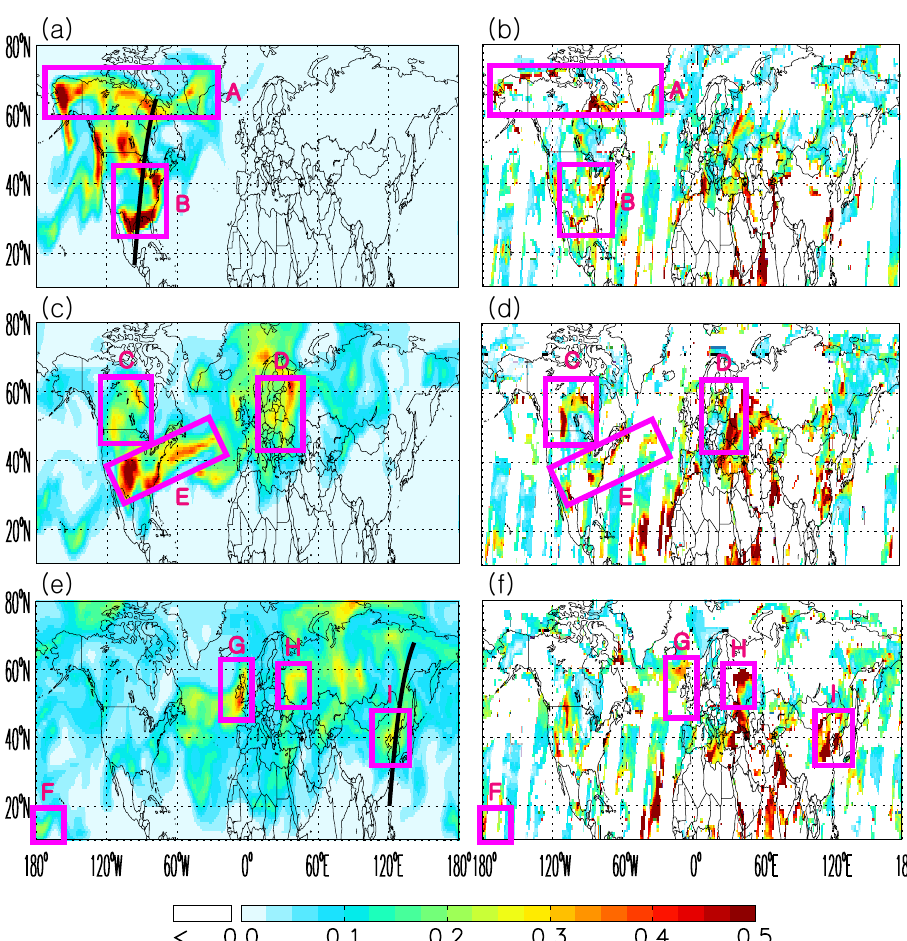
Fig. 5. Spatial distribution of volcanic sulfate aerosol optical depth (AOD) at 550nm as simulated by GEOS-Chem (left column) and as retrieved by MODIS (right column) on 14 (top row), 19 (middle row), and 25 (bottom row) August 2008, respectively. The solid black lines in (a) and (e) respectively indicate the ground tracks of CALIOP data that are shown in Fig. 6a and c. The pink rectangles and letters highlight the regions of large volcanic AOD, as discussed in Sect.